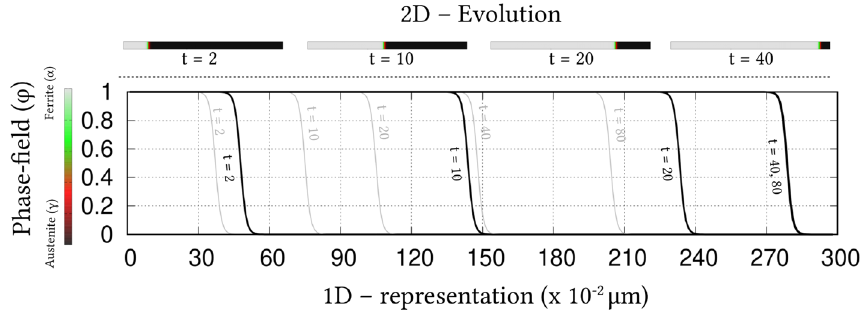
Figure 11. Spatio-temporal evolution of phases in two- and one-dimensional domain (top and bottom, respectively) reflecting austenite decomposition under paraequilibrium. The growth of ferrite under orthoequilibrium in included in one-dimensional plot for comparison.